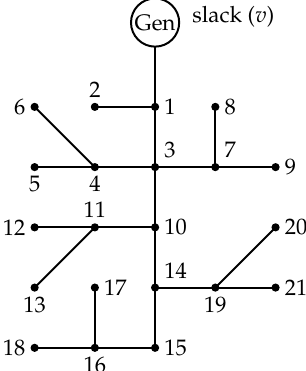
Figure 5. Line diagram of the 21 bus test system.